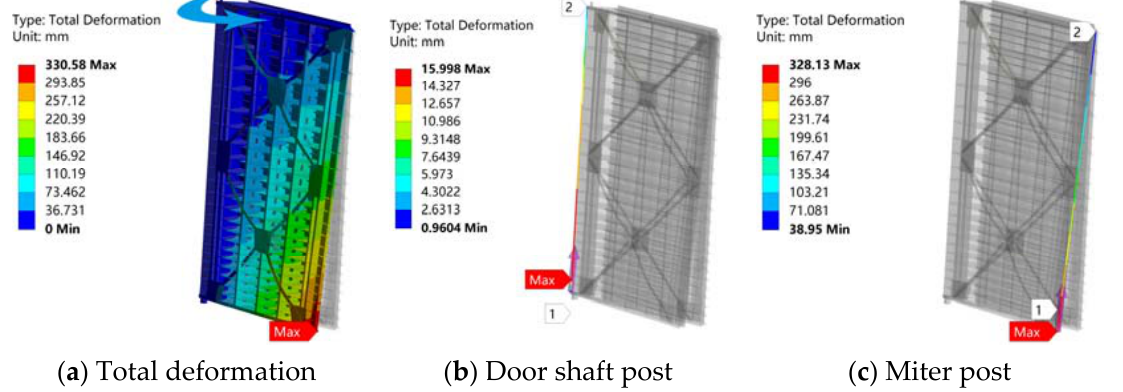
Figure 16. ( a ) Deformation of the overall gate, ( b ) Deformation of the door shaft column, and ( c ) Deformation of the miter column under the door-opening condition.